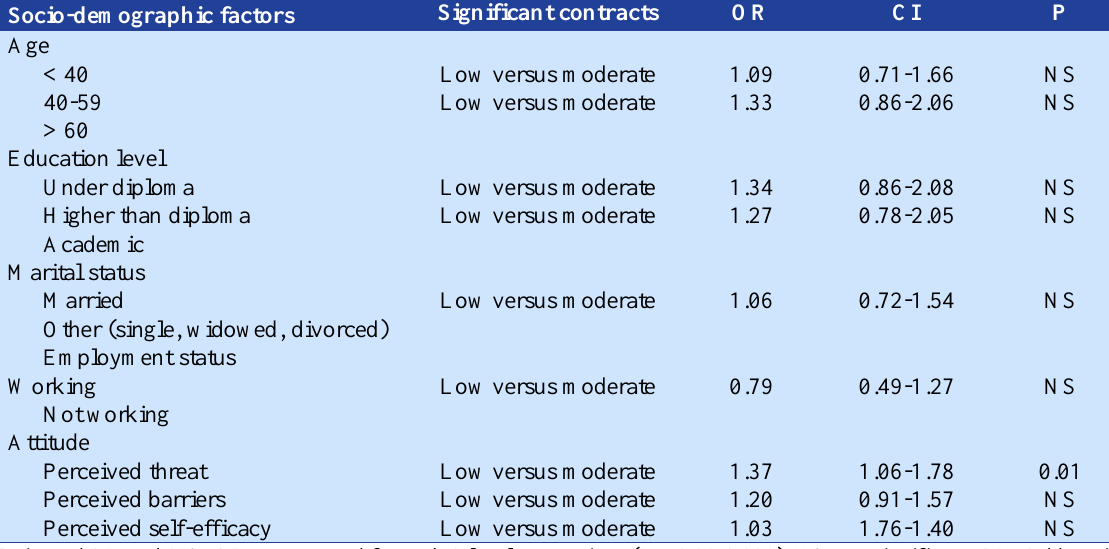
Table 4. Odds awareness level by socio-demographic and attitude Socio-demographic